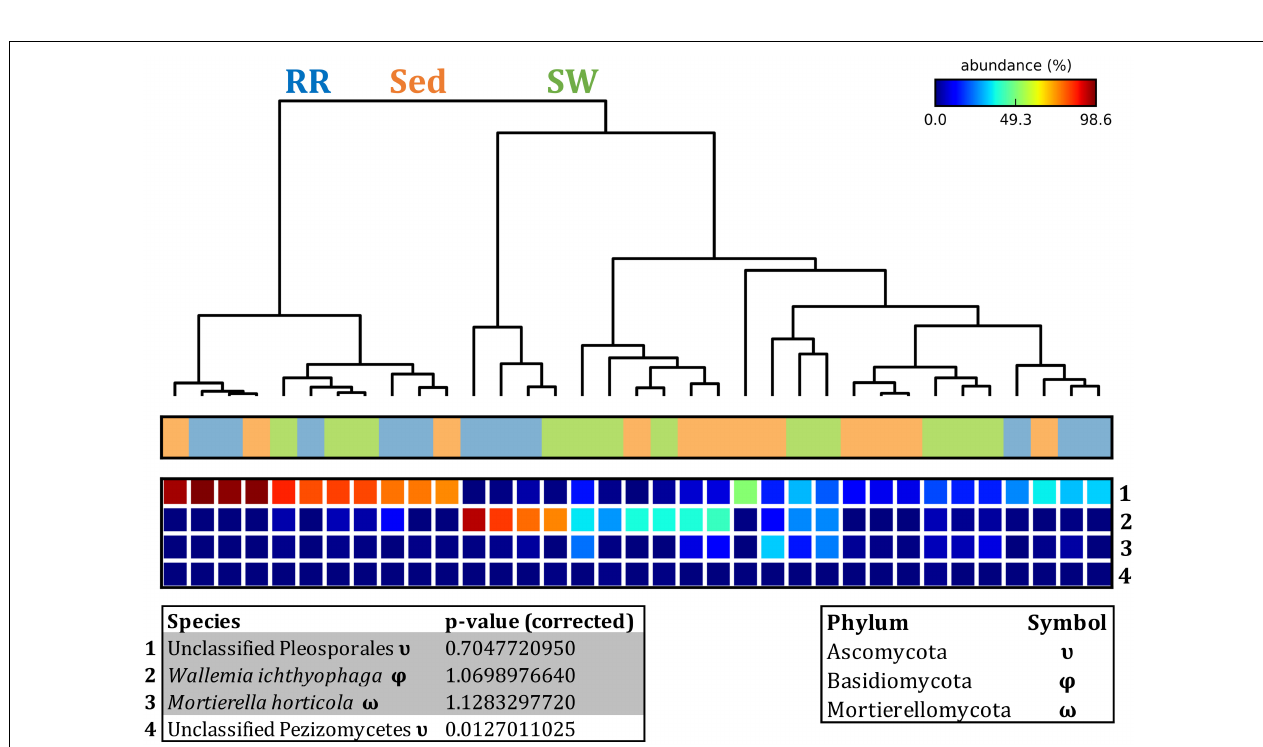
FIGURE 12 | Fungal discriminatory OTUs at the microenvironmental scale. Extensive hypothesis testing of taxonomic profiles was coupled with similarity percentages analyses (SIMPER) for fungal microbiomes across microenvironments. The proportion of sequences (mean frequency %) of OTUs significantly over-represented (Kruskal–Wallis H -test, α = 0.05, effect sizes: η 2 ) and consistently contributing to the differences between microenvironments is indicated by varying color intensities. Corrected p -values were calculated using the Benjamini–Hochberg’s approach. Two-way crossed SIMPER analyses were performed with site and microenvironment variables as factors (S17 Bray–Curtis similarity matrix). High contributors were selected from the top-5 contributors of each pair-wise comparison between microenvironments, and those OTUs consistently accounting for the dissimilarities between any given microenvironment and the other two microenvironments were chosen as high contributors to couple with the statistical results. High contributors that were significantly over-represented were classified as discriminatory OTUs (i.e., 1–4). OTUs are sorted by decreasing mean abundance, and samples are clustered by average neighbor distance (UPGMA, distance threshold = 0.75) and colored by microenvironment. Different symbols represent the distribution of enriched phyla. High contributors that were not significantly over-represented (gray) were also classified as discriminatory OTUs if their contribution to the differences between microenvironments was consistent. RR, roots and rhizomes; Sed, sediment; SW,